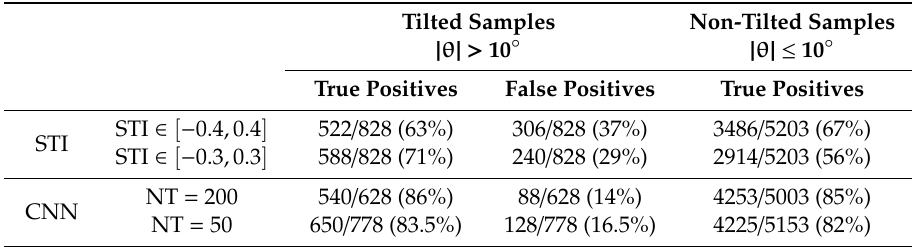
Table 1. Identification of tilted (| | > 10°) and non-tilted (| | ≤ 10°) samples using Swimming Tilt Indicator (STI) and a Convolutional Neural Network (CNN) to dismiss tilted samples in the acoustic-optical (AO) measurements. NT = Number of tilted and non-tilted images used for network training.